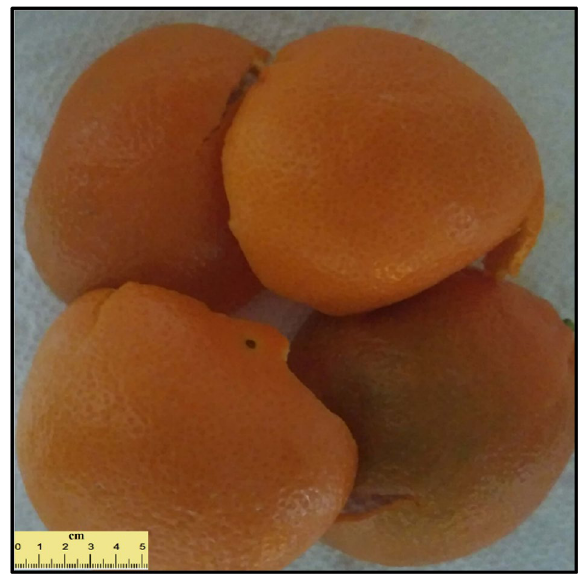
Fig. 1 The raw waste of mandarin